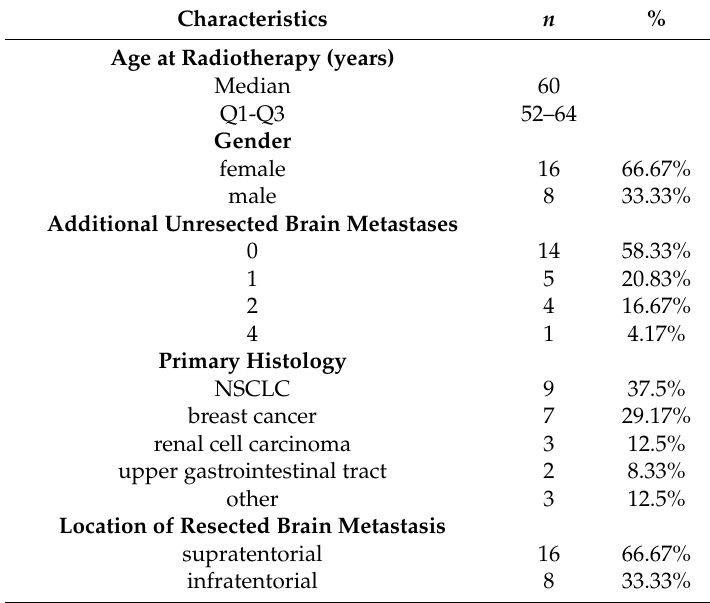
Table 1. Patient characteristics ( n = 24).